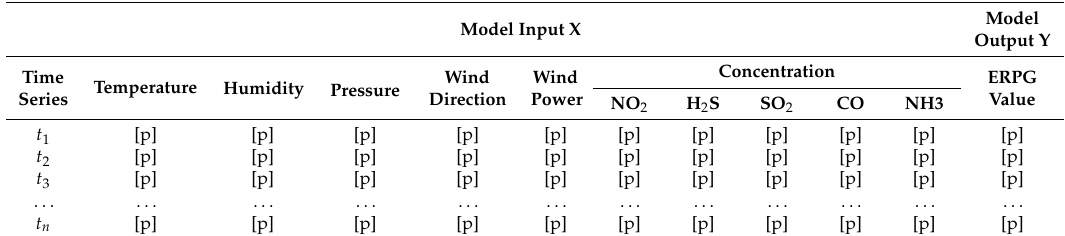
Table 3. Model training data set data structure